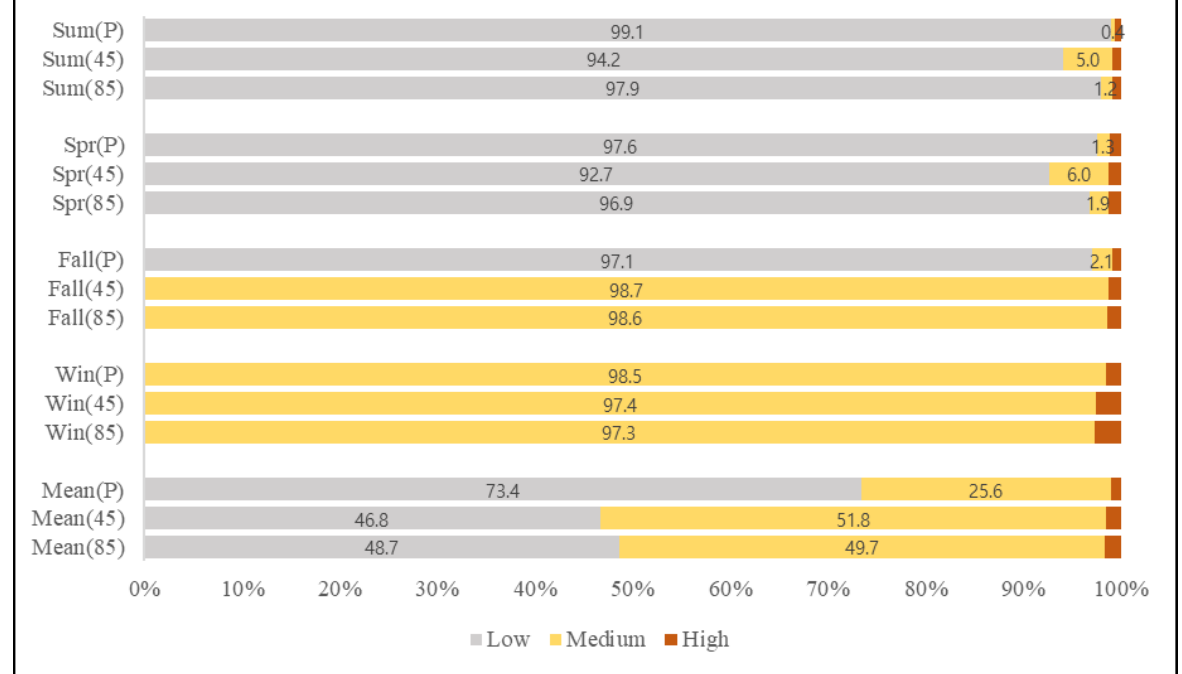
Figure 6. Mean and Seasonal NO 2 concentration comparison for present and future scenarios at the whole study area (P = present; 45 = future scenario 4.5; 85 = future scenario 8.5).